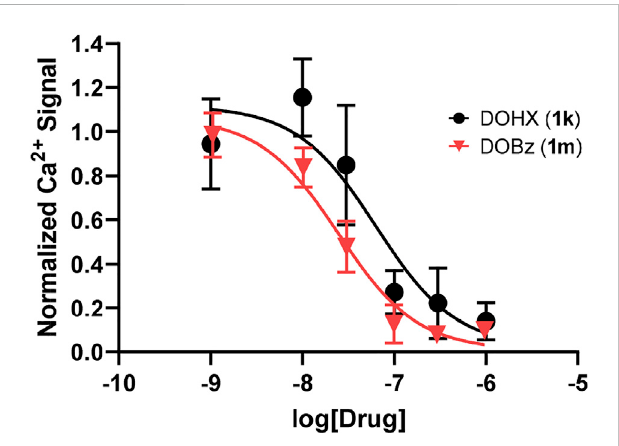
FIGURE 2 5-HT 2B receptor antagonist data with 1k (DOHX) pIC 50 = 7.2 ± 0.18 (63.6 nM) and 1m (DOBz) pIC 50 = 7.61 ± 0.08 (24.6 nM) in the presence of 10 nM of 5-HT.